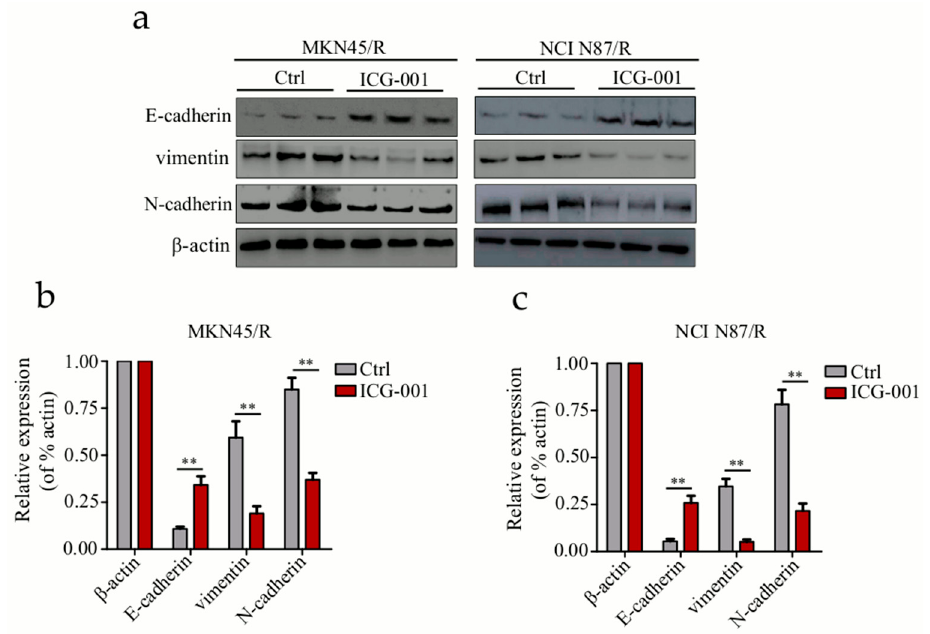
Figure 8. Inhibition of Wnt/ β -catenin pathway by ICG-001 reverses EMT in trastuzumab resistant gastric cancer cells. ( a ) Western blot analysis of E-cadherin, N-cadherin, and vimentin in trastuzumab resistant cells before and after 48 h ICG-001(6 μΜ ) treatment; ( b , c ) Expression of E-cadherin, N-cadherin and vimentin were normalized against β -actin. The results are expressed as mean ± SEM of three independent experiments. ** p < 0.01 vs. control.